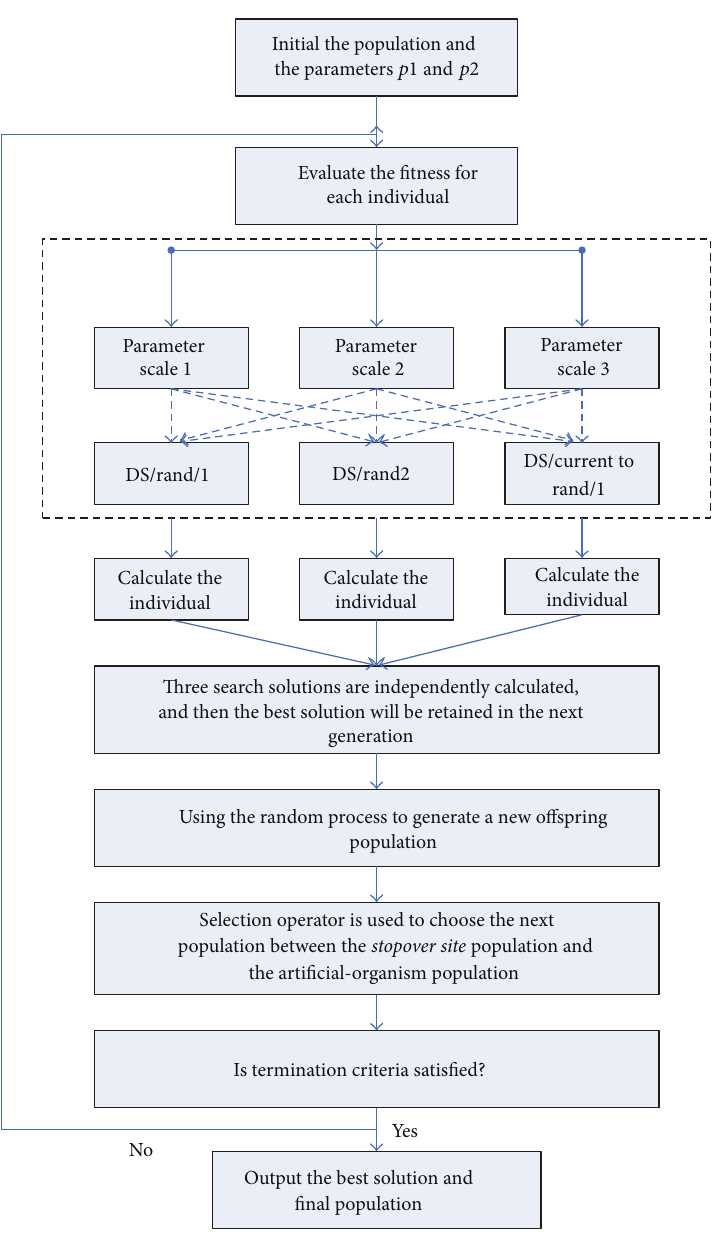
Figure 1: Flowchart of the CDS